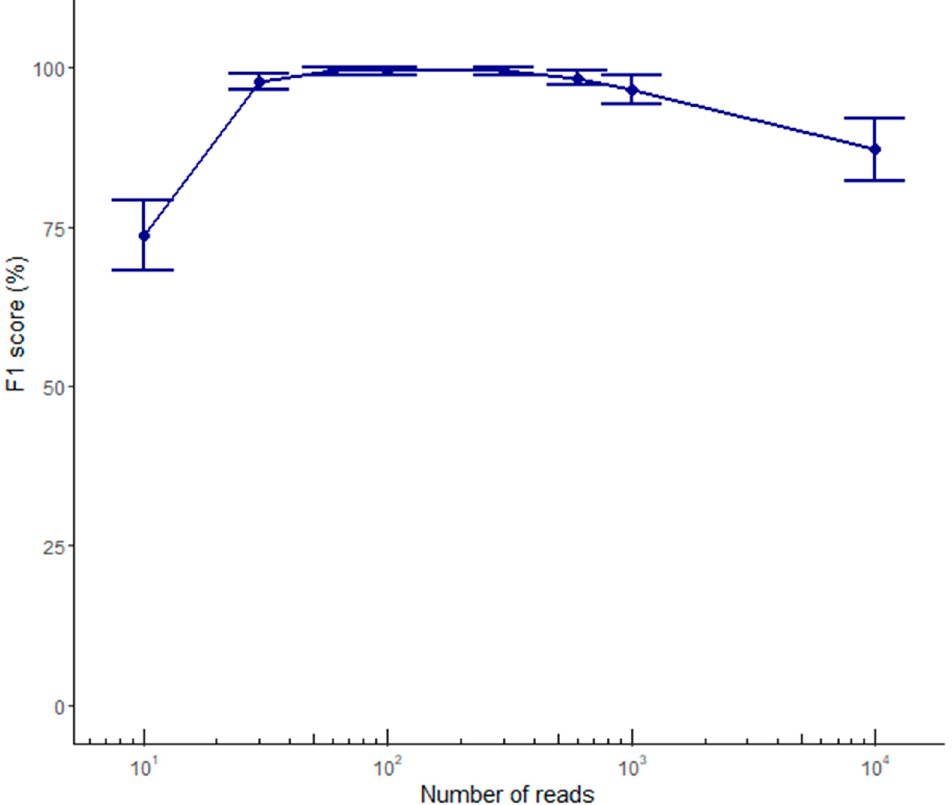
Figure 4. Accuracy of SNV calling from ONT reads. The graph shows the harmonic mean of precision and recall for SNV calling as an F1 score averaged across samples, when different numbers of ONT reads (10, 30, 60, 100, 300, 600, 1000, or 10,000) are used. Error bars represent the standard error.